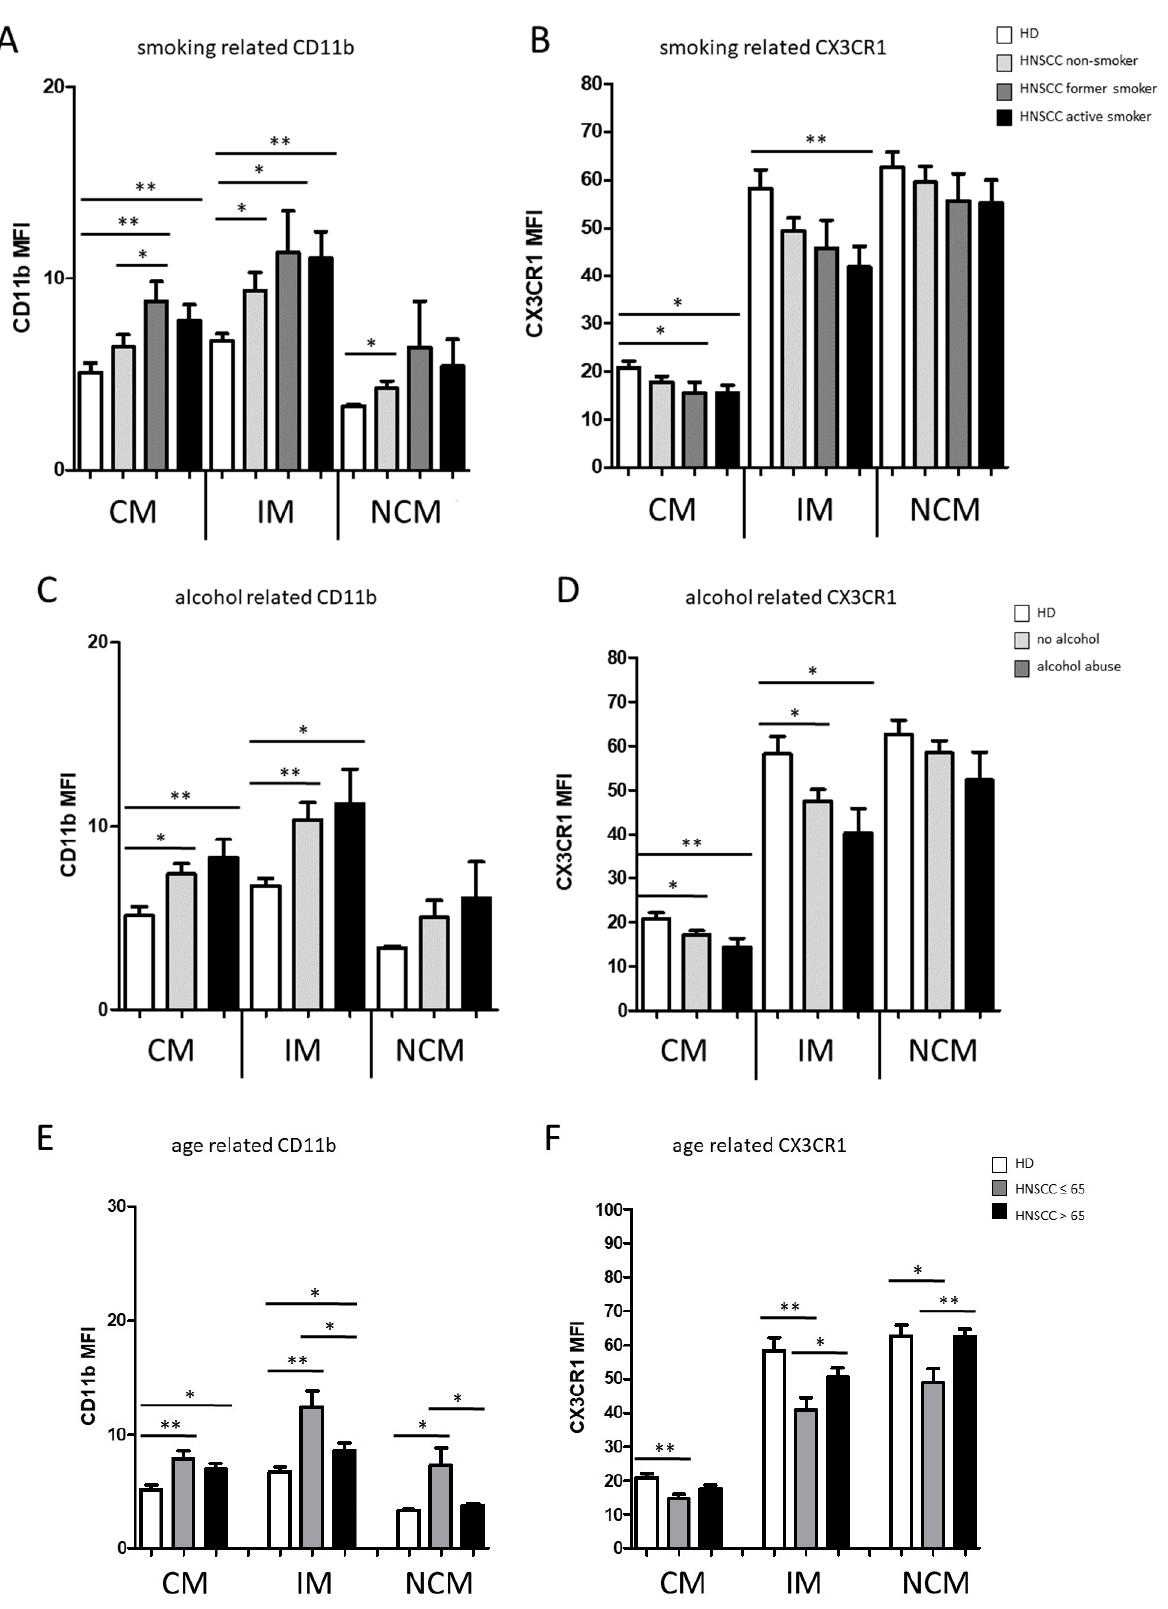
Figure 3. Flow cytometric analysis of monocytic CD11b and CX3CR1 expression in classical mono- cytes (CM), intermediate monocytes (IM), and non-classical monocytes (NCM) in PBMC from healthy donors and HNSCC patients. ( A ) Active-smoking HNSCC patients revealed significantly increased expression levels of monocytic CD11b compared to healthy donors. ( B ) HNSCC patients revealed significantly decreased expression levels of monocytic CX3CR1 in classical monocytes and intermediate monocytes from active-smoking patients compared to healthy donors. ( C ) HNSCC pa- tients revealed significantly increased expression levels of monocytic CD11b compared to healthy donors. ( D ) HNSCC patients revealed significantly decreased expression levels of monocytic CX3CR1 in classical monocytes and intermediate monocytes compared to healthy donors. ( E ) HNSCC patients ≤ 65 revealed significantly increased expression levels of monocytic CD11b com- pared to healthy donors and HNSCC patients ˃ 65. ( F ) HNSCC patients ≤ 65 revealed significantly decreased expression levels of monocytic CX3CR1 compared to healthy donors and HNSCC pa- tients ˃ 65. * p < 0.05; ** p < 0.01. Similar results were obtained from the analysis of alcohol-abusing HNSCC patients compared to healthy donors (Figure 3C). Conversely, our data revealed significantly de- creased expression levels of CX3CR1 on intermediate monocytes in active-smoking HNSCC patients compared to healthy donors (Figure 3B,D). In view of older HNSCC pa- tients, data revealed an inverse regulation with significantly decreased expression of mon- ocytic CD11b and increased expression of CX3CR1 in older HNSCC patients compared to the cohort of HNSCC patients ≤ 65 years of age (Figure 3E,F). A subsequent correlation analysis between monocytic CD11b and CX3CR1 expression of HNSCC patients revealed an overall highly significant negative correlation in all three monocyte subsets (Figure 4).